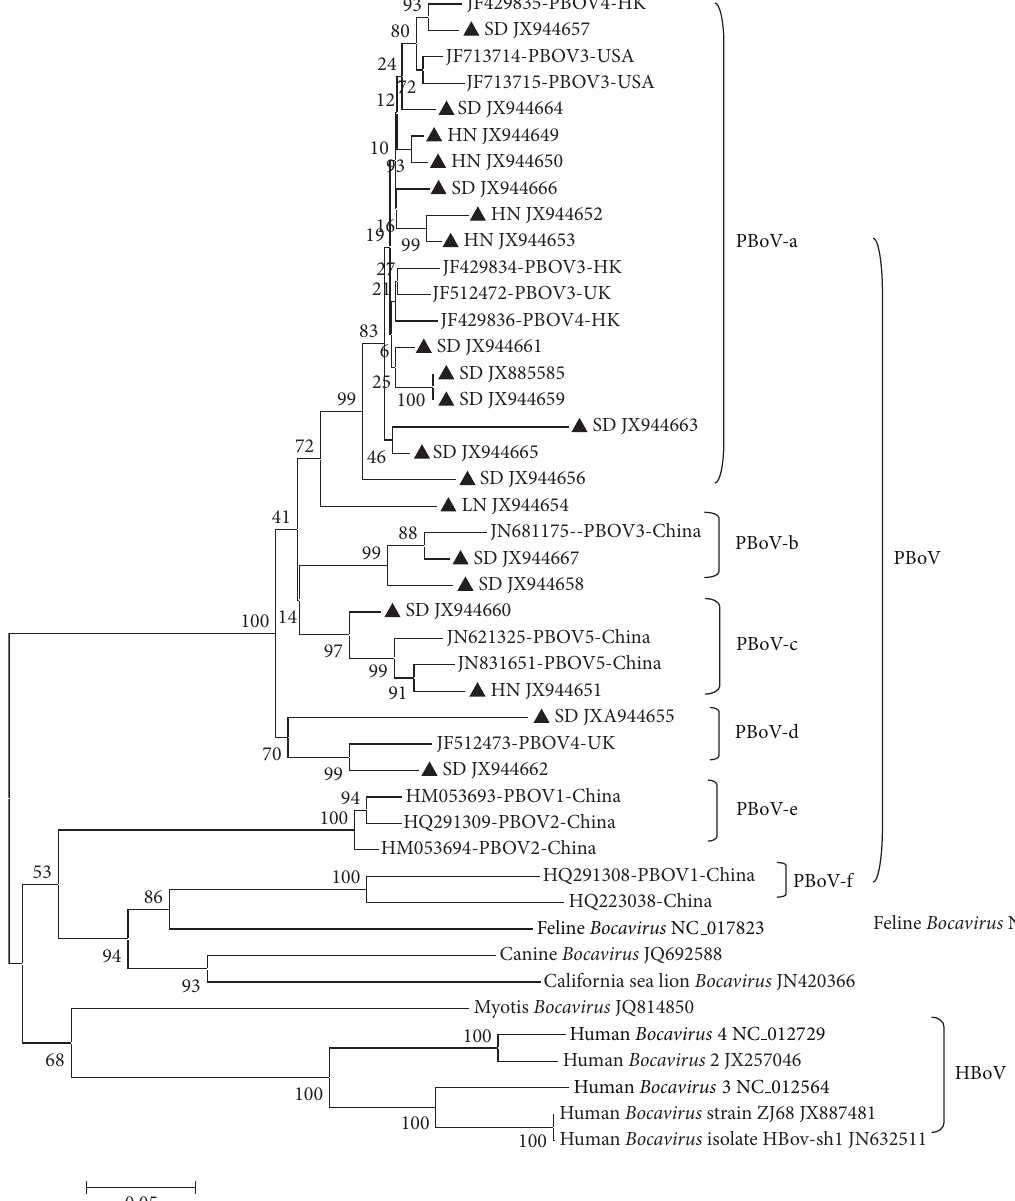
Figure 1: Phylogenetic tree constructed based on partial NS1 sequences of reference PBoV and PBoV from Chinese slaughter pigs. Slaughter pig sequences are labeled with 󳵳 and their corresponding accession numbers. The phylogenetic tree was constructed by MEGA ver. 5.1 with neighbor-joining method using 1,000 bootstrap